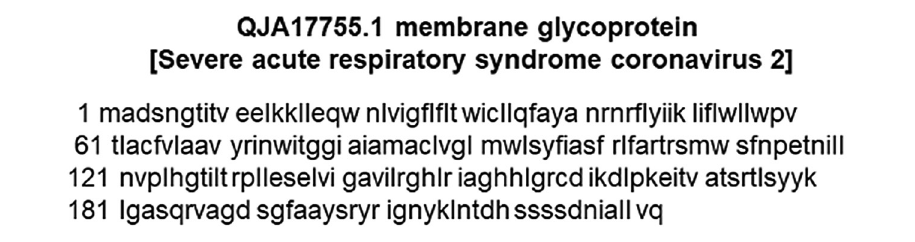
Figure 1. The protein sequence of the M glycoprotein of SARS-CoV-2. The sequence was downloaded from the NCBI protein